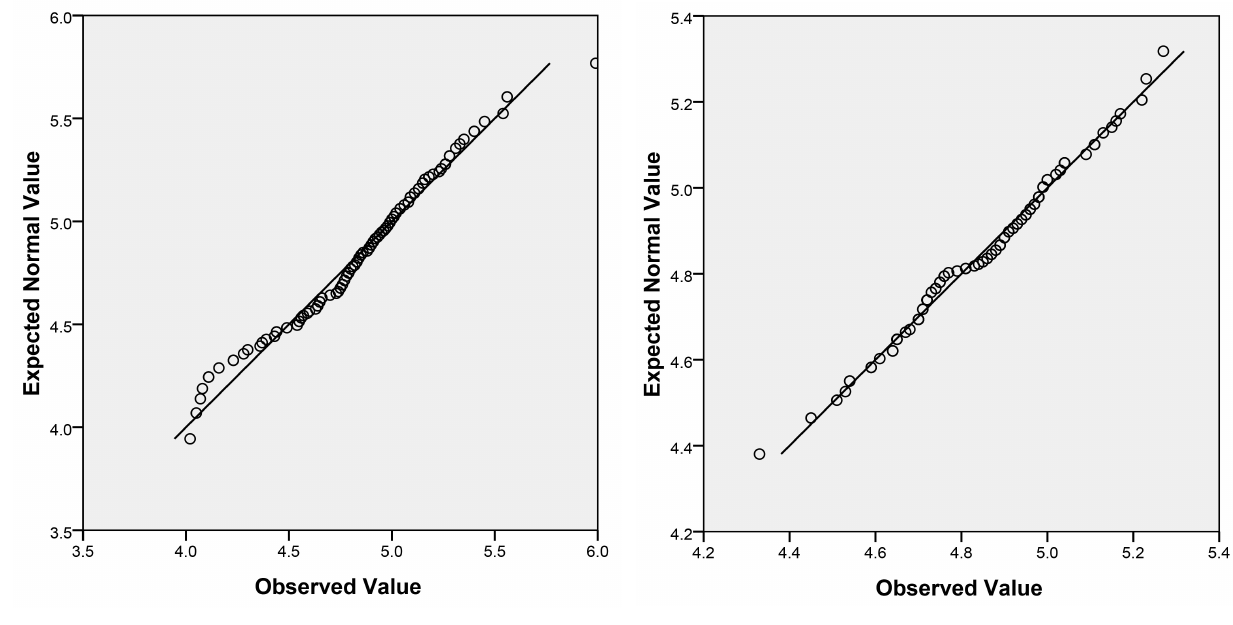
Figure 1. Q–Q plot of measured and predicted soil